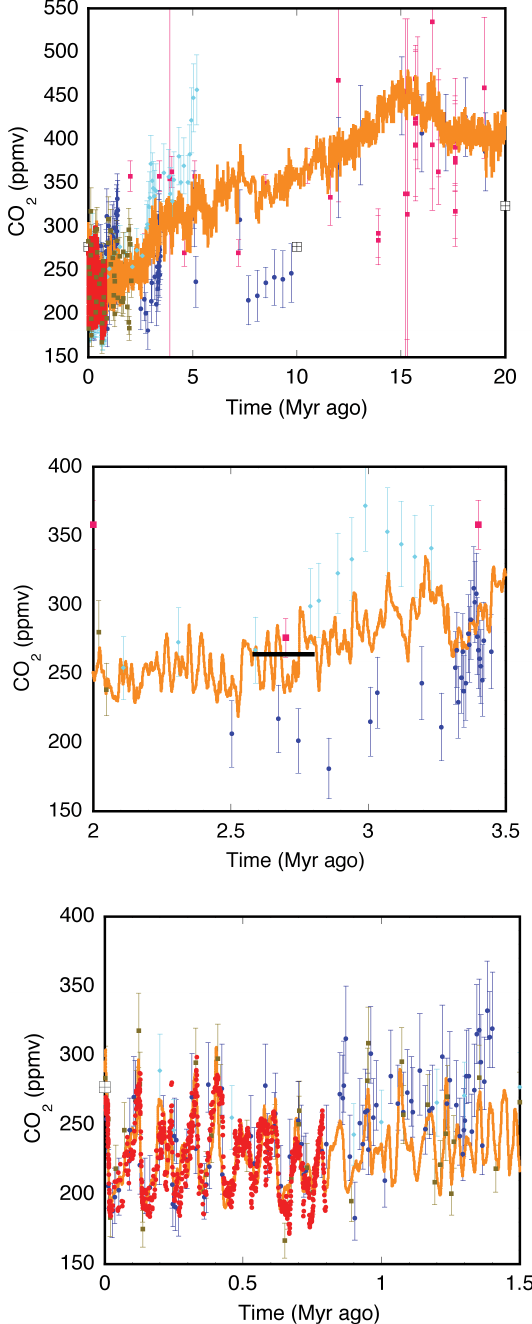
Fig. 6. Comparison of reconstructed CO 2 record with C = 39K, with proxy records (symbols as in Fig. 3). Panel (a) for the full 20Myr period, (b) for the period around the Northern Hemisphere glacial inception and (c) for the mid-Pleistocene transition. Note that the vertical scale is different for the different panels. The Hor- izontal bar in panel (b) indicates the onset of major glaciation in the Northern Hemisphere. The crosses with open squares are the GEOCARB